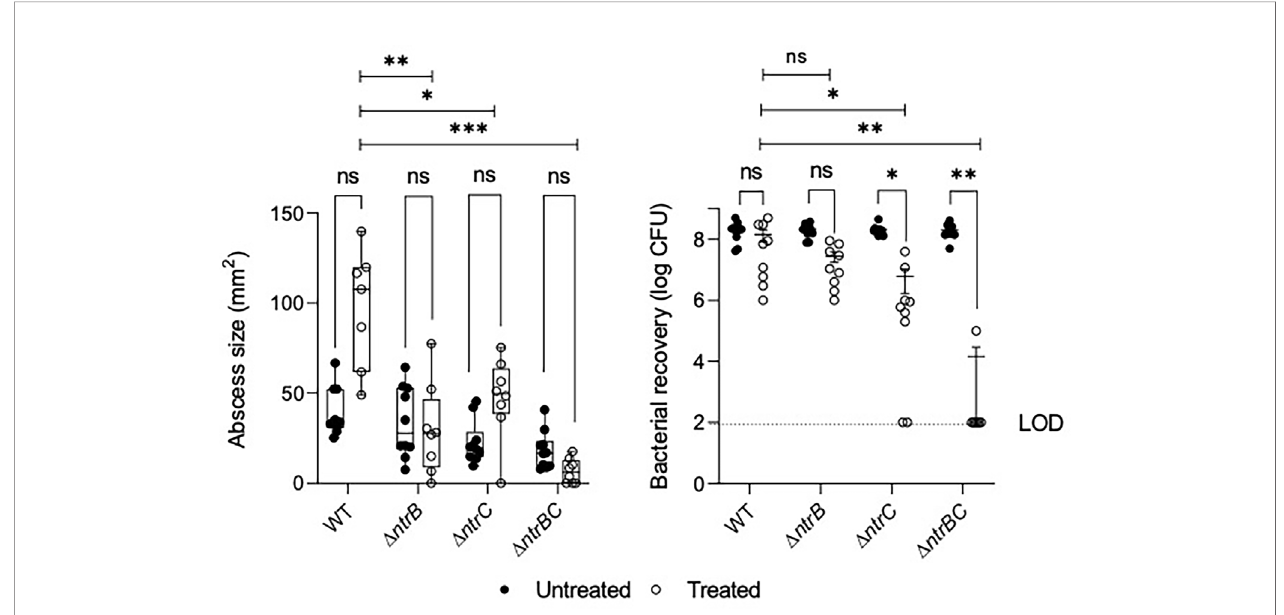
FIGURE 2 | Mutation of the nitrogen regulatory two-component system, NtrBC, sensitized P. aeruginosa LESB58 to cipro fl oxacin treatment in vivo . Abscesses formed by LESB58 D ntrBC following cipro fl oxacin treatment (0.1 mg) were signi fi cantly smaller and contained fewer bacteria than those formed by WT. Brie fl y, mice were subcutaneously injected 5 x 10 7 planktonic cells and treated 1 h later. After 72 h, abscesses were measured and harvested in phosphate buffered saline (PBS), homogenized and plated on LB for bacterial enumeration. Box and whiskers delineate interquartile range with geometric error from three independent experiments containing 2-3 biological replicates each ( n = 8-10). Bacterial recovery data are reported as geometric mean ± standard deviation (SD). * P < 0.05, ** P < 0.01, *** P < 0.001, ns, not signi fi cantly different compared to WT according to Two-Way ANOVA followed by Dunnett ’ s post-hoc